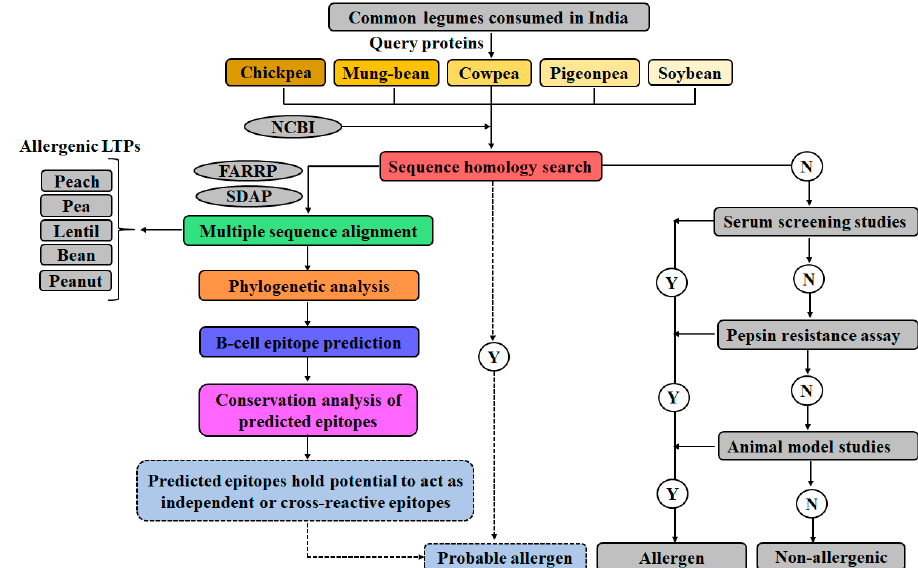
Figure 1. Schematic representation of the workflow employed in the study to evaluate the aller- genic potential of five legume LTPs, and mapping of the linear and conformational B-cell epitopes; NCBI (National Center for Biotechnology Information); FARRP (Food Allergy Research and Re- source Program); SDAP (Structural Database of Allergenic Proteins); Y (Yes); N